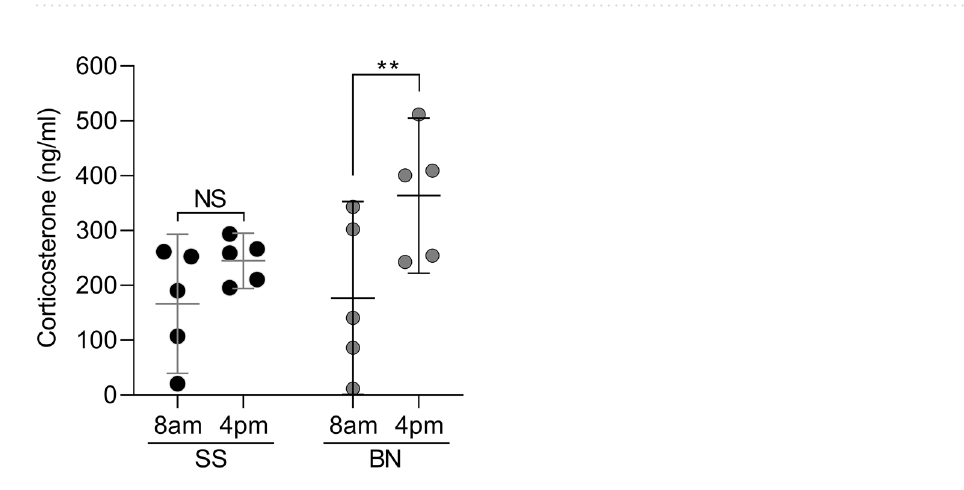
Figure 4. Participation of oxidative stress in the SS phenotype. SS (full symbols) and SD (empty symbols) rats were treated with the antioxidant tempol (10 nM) dissolved in the drinking water for 14 consecutive days. Mechanical nociceptive thresholds were evaluated by the Randall-Selitto test every other day until the 20th day. While tempol treatment did not impact the nociceptive threshold in the SD group (F (3.885, 27.19) = 0.4894, p = 0.7384 when the nociceptive threshold over time was compared to the baseline, one-way repeated measures ANOVA followed by Bonferroni posttest), it produced a robust change in the SS group (F (3.724, 26.07) = 29.63, p < 0.0001), significant after the 4th day of treatment (** p = 0.0003), that persisted until the 14th day (*** p = 0.0002 when compared to the baseline). After the treatment was interrupted, the SS nociceptive thresholds returned to levels not significantly different from the baseline by day 16 ( p = 0.3833, NS). n = 8 per group.